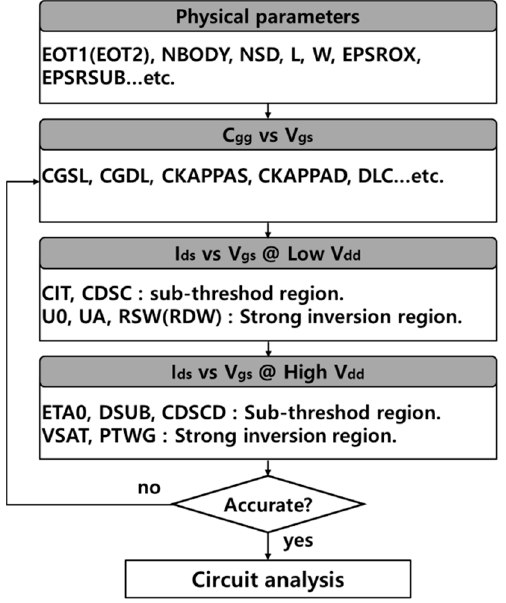
Figure 2. BSIM-IMG model parameter extraction flow used in this work.